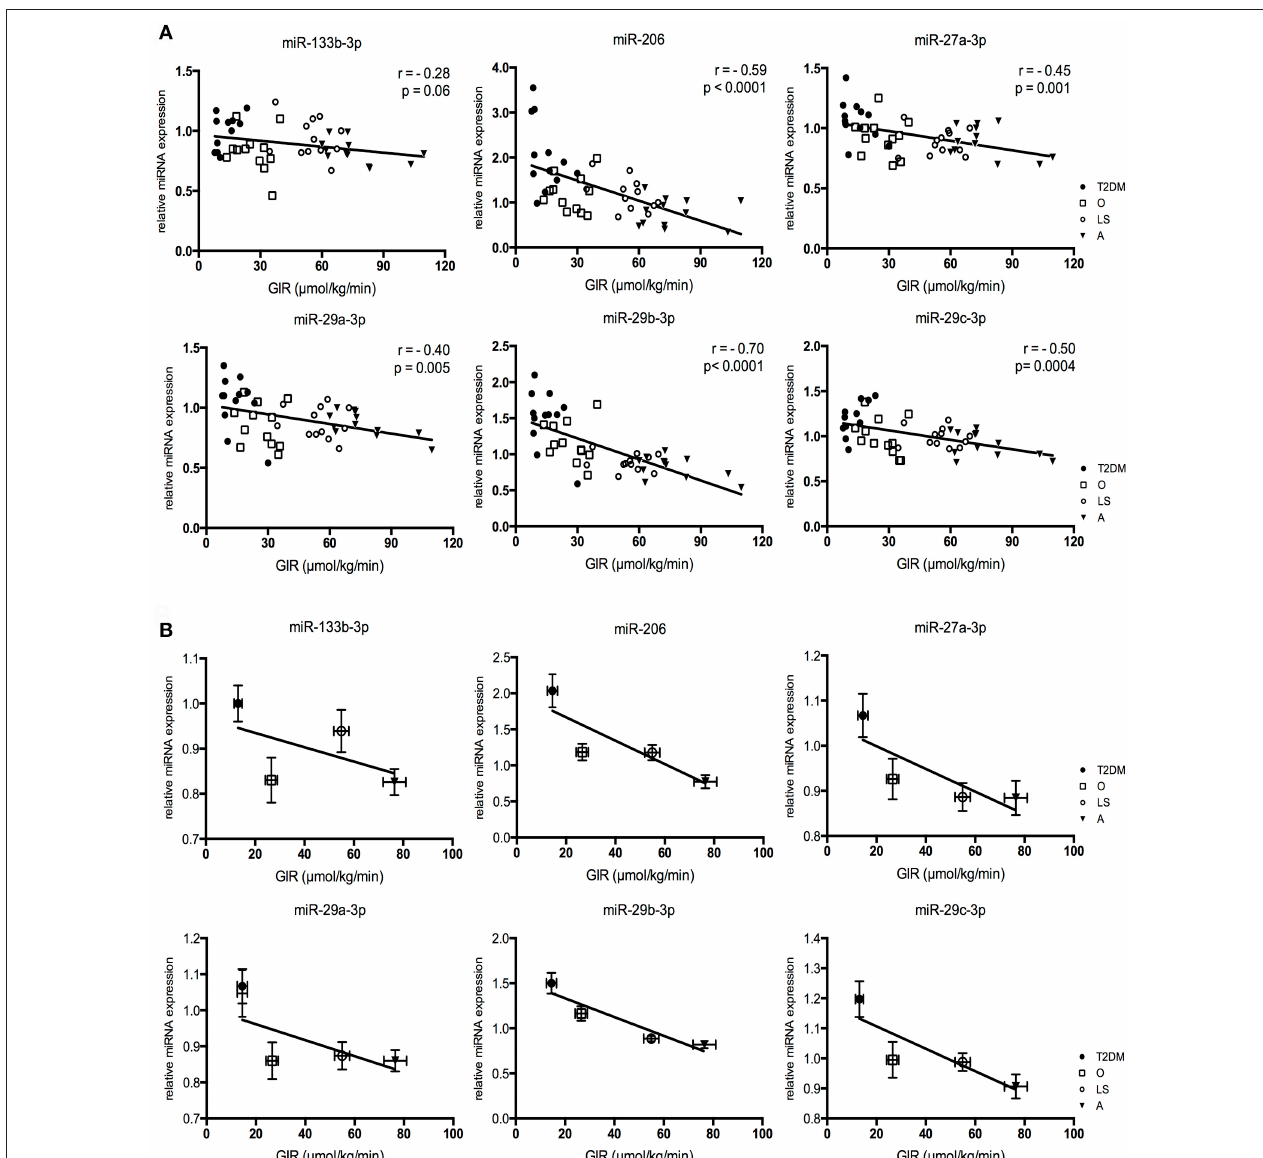
FIGURE 3 | Correlations for miRNA expression levels plotted against glucose infusion rate (GIR), with the Pearson r (r) and p -value (p) given for each correlation (A) . Relative miRNA expressions vs. glucose infusion rate per subject group (B) . Graphs represent mean ± SEM per group.